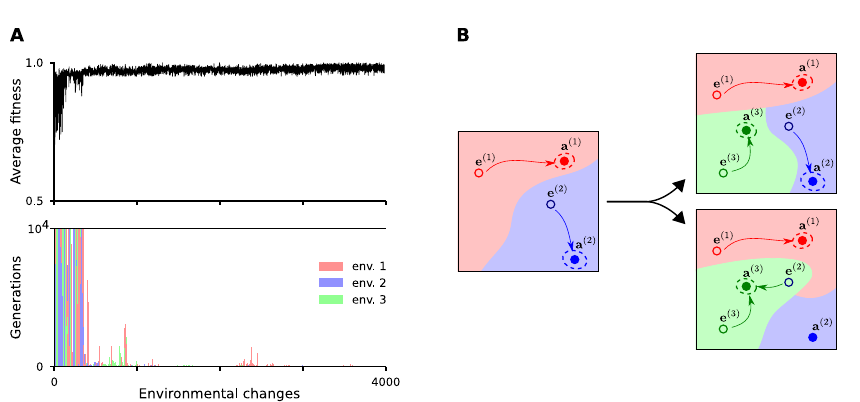
Fig 6. Learning of three different developmental pathways in the evolutionary model. (A) Average fitness and the mutation-selection steps needed to achieve a well-functioning developmental network during random environmental changes. The three environments are denoted by red, green and blue. Parameters as in Fig 5. (B) Schematic illustration of the changes in the state-space dynamics during the evolutionary process with three developmental pathways (indicated by red, blue and green colors). The panels show the basins of attraction of an initial, random regulation system with two embryo-adult pairs (left), a well-functioning one (top right) and a bad one, where the basins of attraction of the adult states (filled dots encircled by dotted lines indicating variation around the target phenotypes) include not only their corresponding embryo states (bottom right).